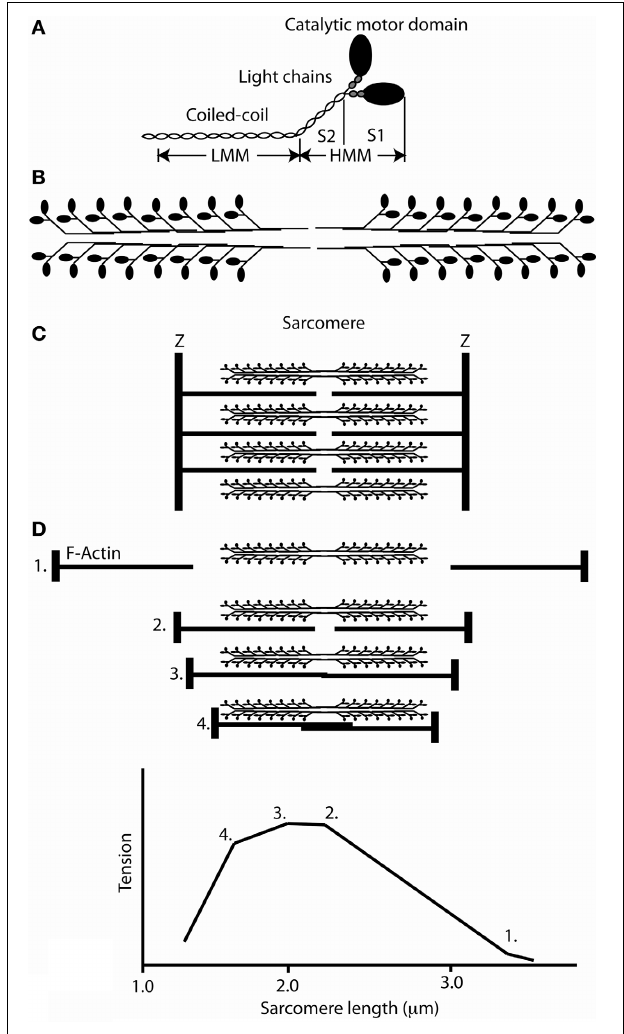
FIGURE 1 | The structure of myosin and the organization of the sarcomere. (A) Schematic cartoon of a skeletal muscle myosin molecule showing the molecule to be a hexamer composed of two heavy chains and two pairs of light chains. The heavy chains dimerize to form a coiled coil which forms the elongated tail of the molecule. The major domains that were initially delineated by controlled proteolysis, HMM, LMM, S2, and S1 are marked. (B) A schematic of the self-association of myosin molecules to form a bipolar thick filament. (C) The organization of actin and myosin in a sarcomere. (D) Upper panel, sarcomeres at various length positions; lower panel, the length tension curve corresponding to the sarcomere lengths